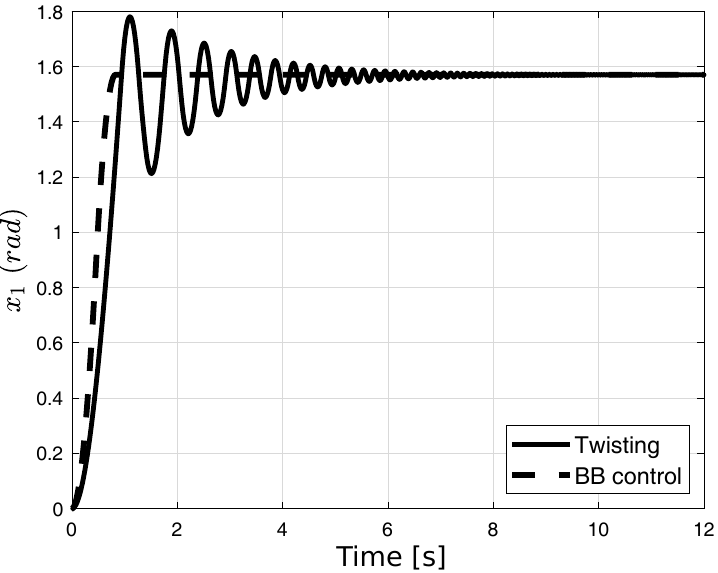
Figure 6. Comparison between the bang–bang controller and the twisting